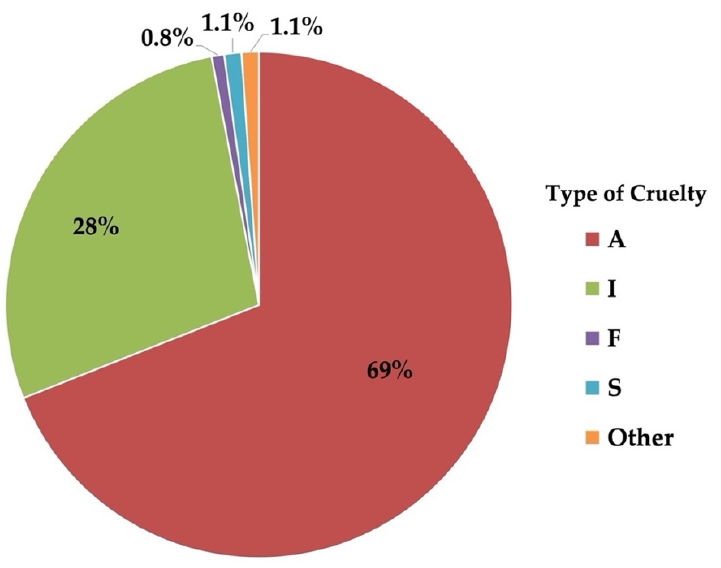
Figure 7. Animal Cruelty Offenses for 2019 by Offense Category (%).